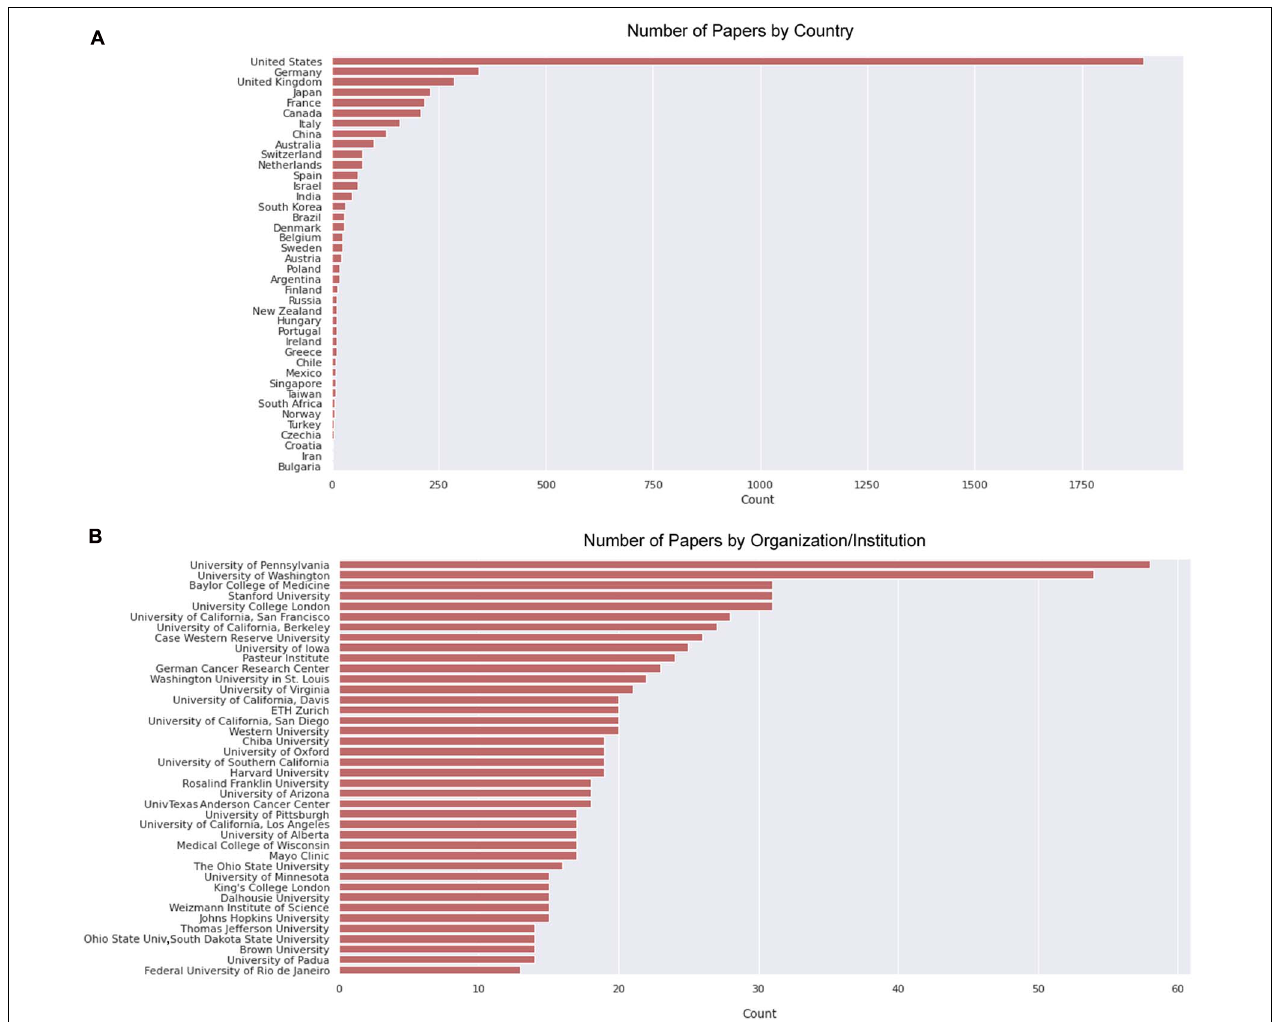
FIGURE 8 | Countries and institutions that harbored most papers on primary culture of embryonic chick myogenic cells. (A) Number of papers by country of the leading institution, as indicated. (B) Number of papers by leading institution. We defined the leading institution as the first affiliation depicted in the retrieved Dimensions dataset, which included publications until the year of